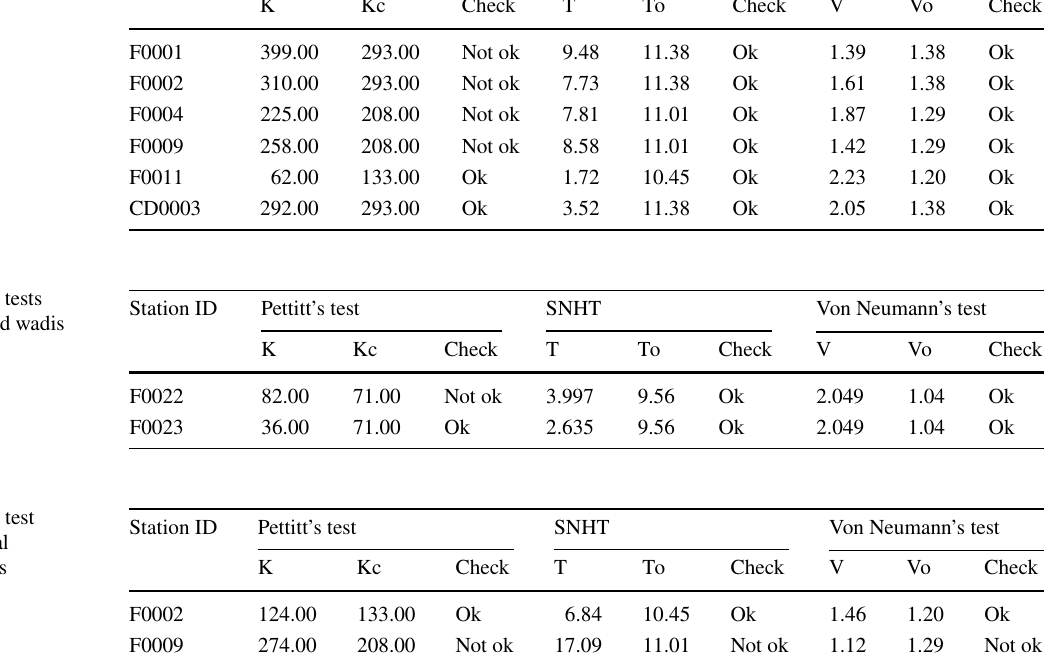
results for total annual rainfall data